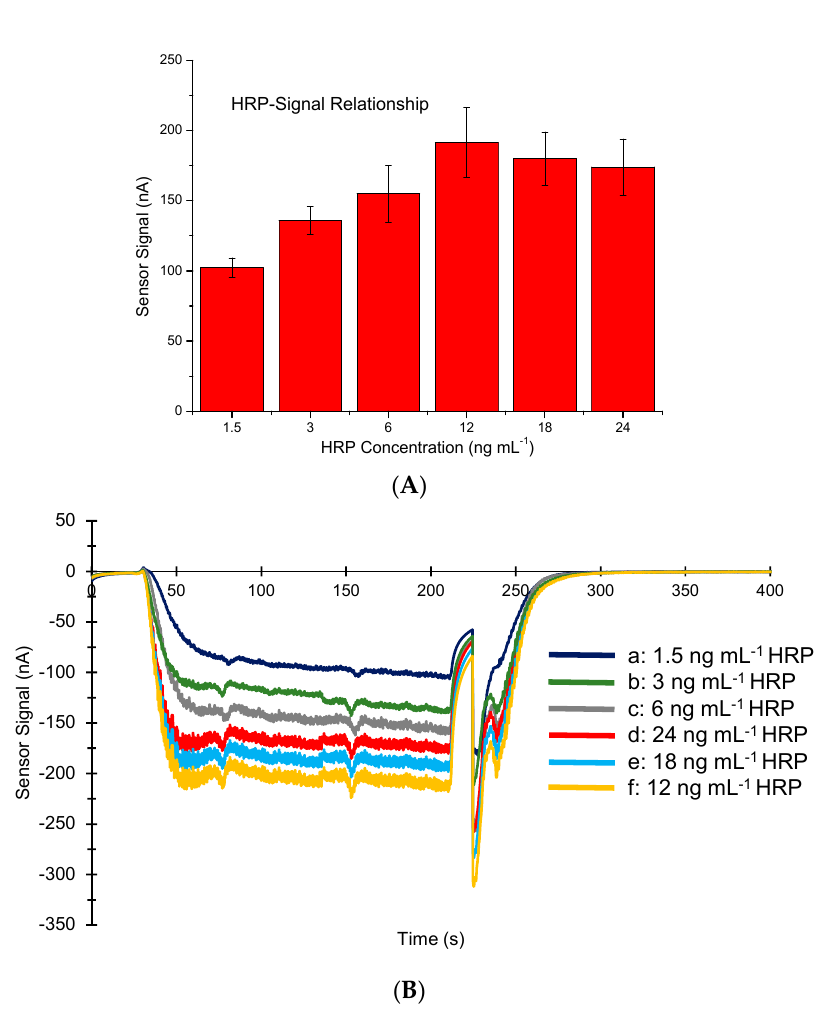
Figure 3. Overall results of HRP-TMB optimization assays in a concentration range of 1.5–24 ng mL − 1 ( A ) and real-time sensorgrams obtained with six different HRP concentrations ( B ).